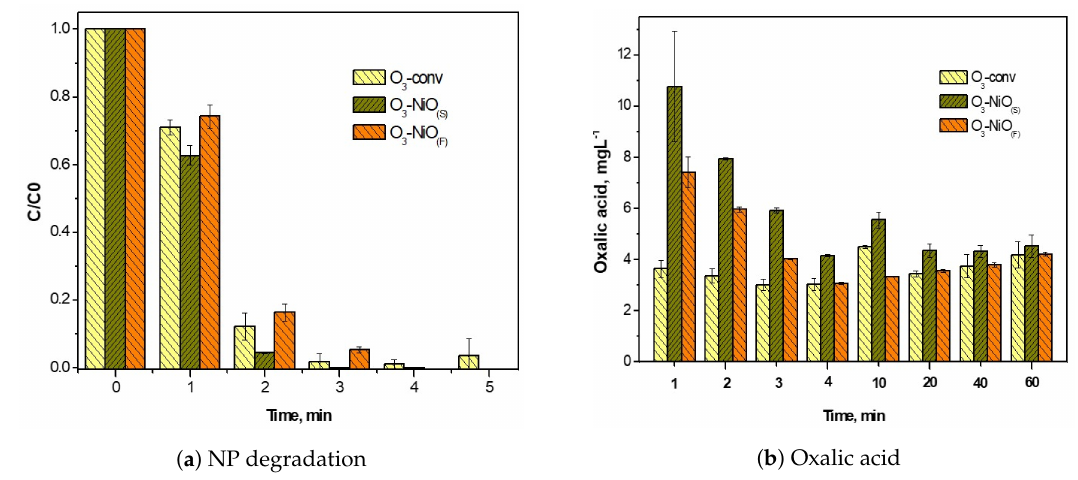
Figure 6. NP [20 mg/L] degradation ( a ) and oxalic acid concentration ( b ) generated by O 3 -conv, O 3 - NiO ( S ) (100 mg/L) and O 3 - NiO ( F ) . [ O 3 ] = 5.5 ± 0.5 mg/L, flow ( O 3 - O 2 ) = 0.5